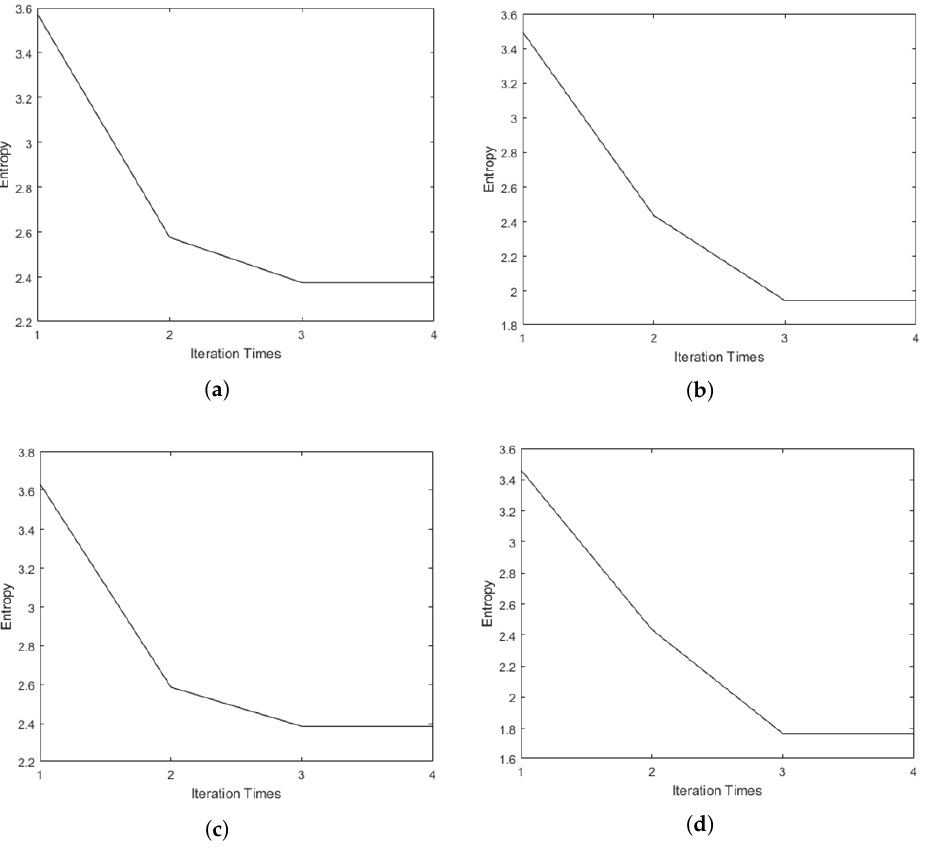
Figure 11. Entropy minimization iteration process. ( a ) Using the entropy minimization principle of the first T/R pair; ( b ) using the entropy minimization principle of the second T/R pair; ( c ) using the entropy minimization principle of the third T/R pair; ( d ) using the entropy minimization principle of the fourth T/R